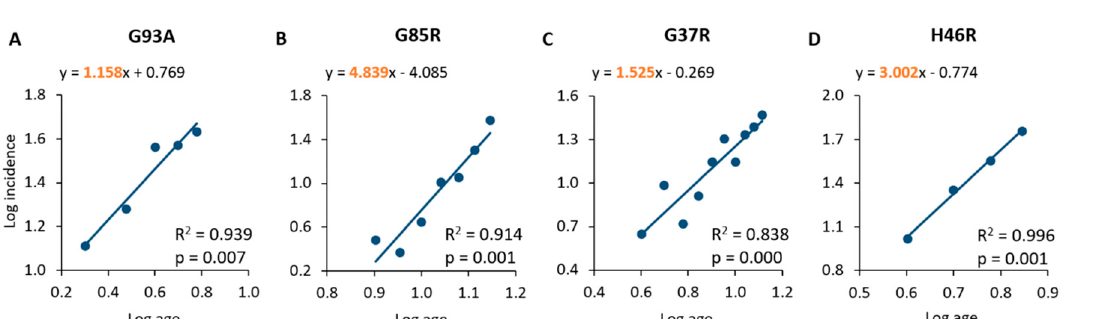
Figure 1. Linear regression and correlation of log age and log incidence in mouse populations of SOD1 G93A ( A ), SOD1 G85R ( B ), SOD1 G37R ( C ) and SOD1 H46R ( D ). The equations of the lines represent- the best fit of linear regression are shown in the graphs. The slopes are highlighted in orange. Table 3. Comparison of the mouse populations overexpressing the SOD1 mutations.